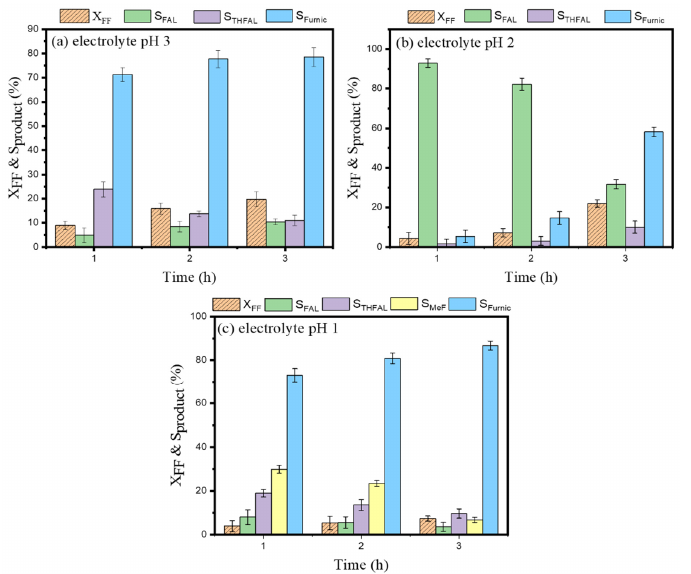
Figure 8. Catalytic performance of Ni 0.85 Pd 0.15 electrode with different pHs of ( a ) 3, ( b ) 2, and ( c ) 1.